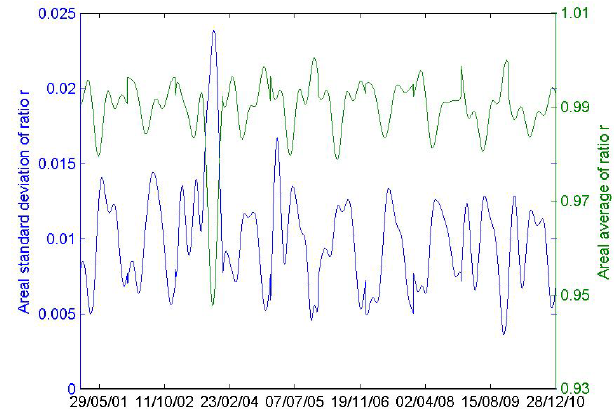
Fig. 3. Daily trend of areal average (green line) and areal standard deviation (blue line) of r ratio from 2001 to